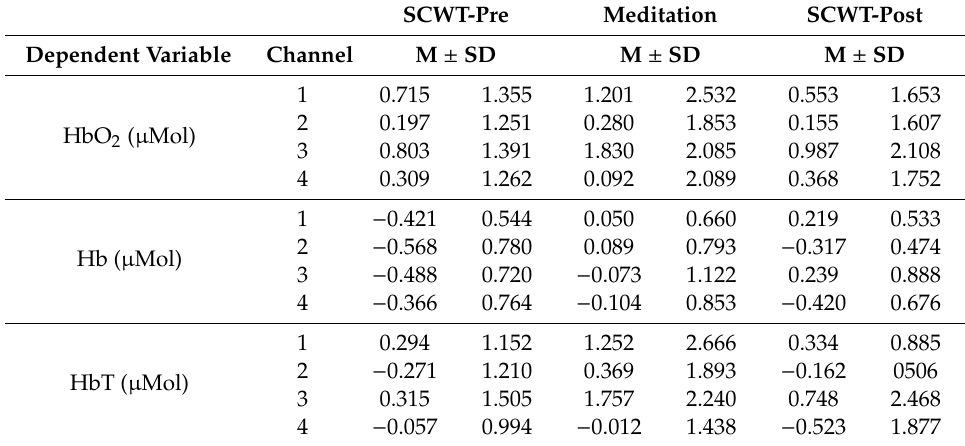
KEY: M—mean; SD—standard deviation; SCWT-pre—Stroop test before meditation; SCWT-post—Stroop test after meditation; HbO 2 —oxygenated hemoglobin; Hb—deoxygenated hemoglobin; Hb—total hemoglobin; µ Mol—mean micromolar